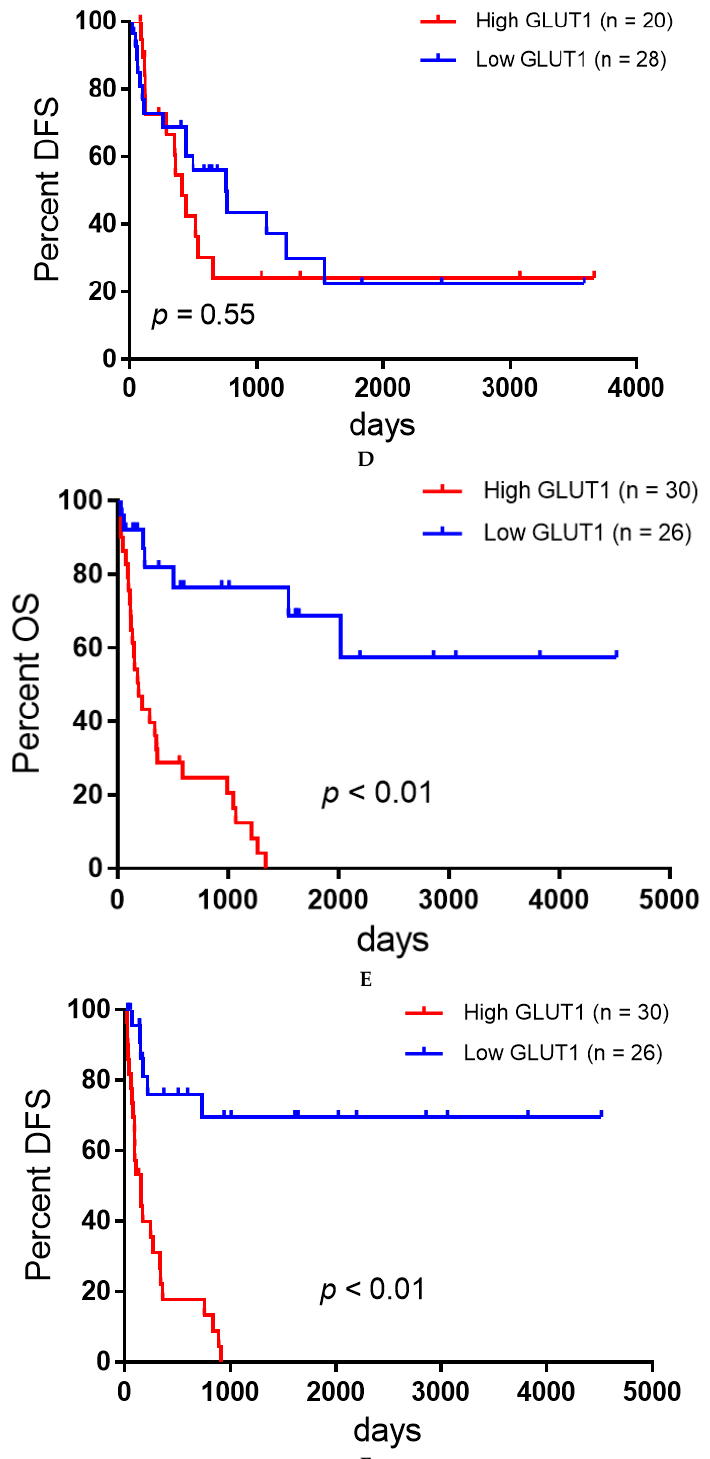
Figure 3. Kaplan-Meier survival curves for all patients ( A , B ), those with adenocarcinoma ( C , D ), and those with nonadenocarcinoma ( E , F ). Patients with high GLUT1 expression exhibited a significantly worse OS (A) and DFS (B) than those with low GLUT1 expression. No significant di ff erence in the OS (C) and DFS (D) was observed between patients with adenocarcinoma with high and low GLUT1 expression, whereas the OS (E) and DFS (F) in patients with nonadenocarcinoma were significantly lower in those with high GLUT1 expression than in those low GLUT1